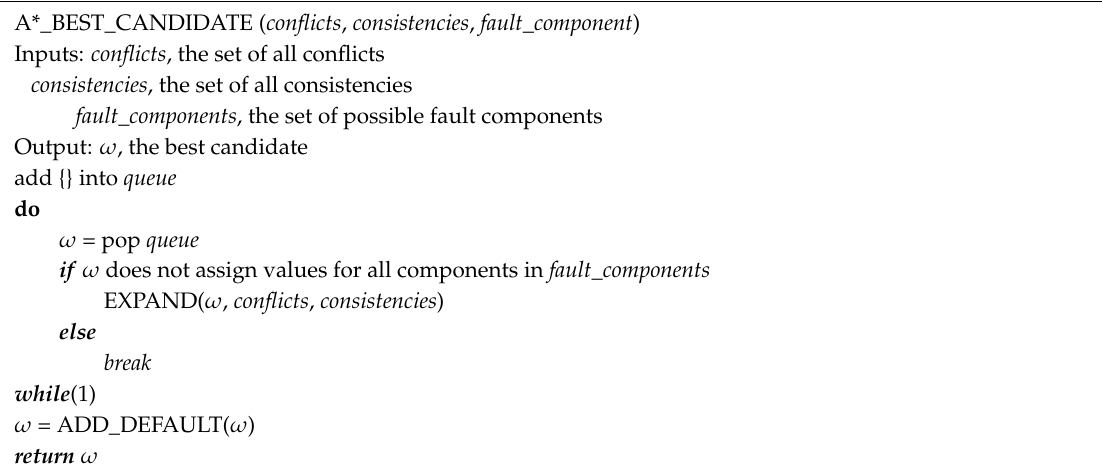
Algorithm 6. Pseudocode of A*_BEST_CANDIDATE for CCDLSA*.